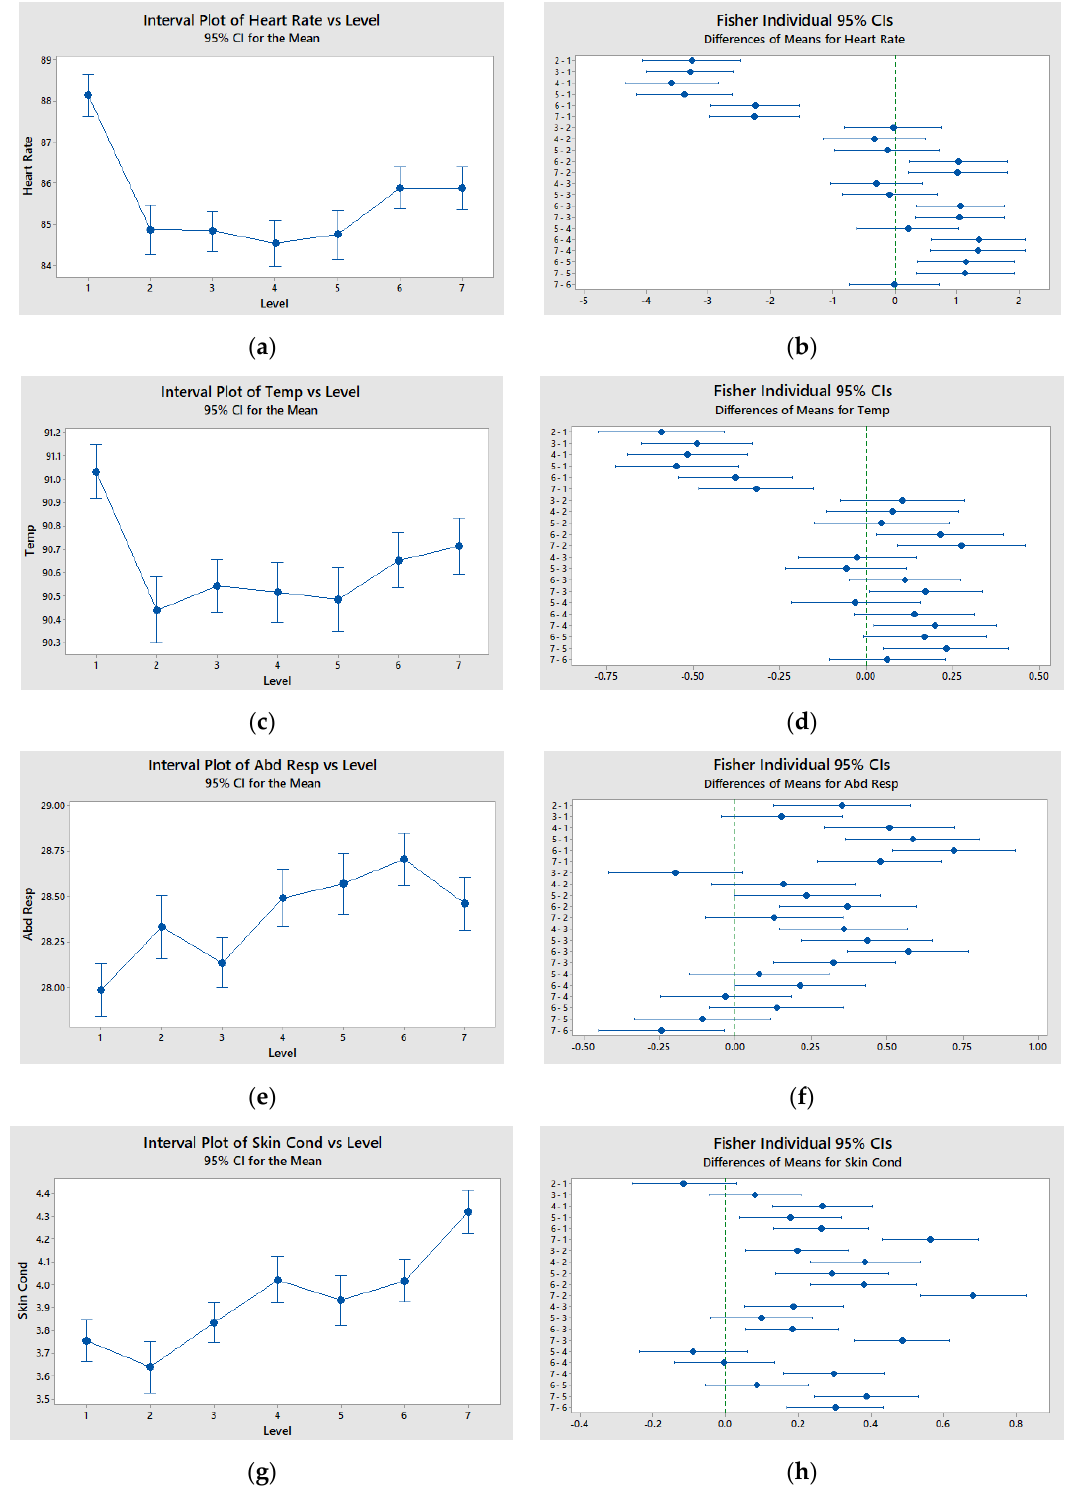
Figure 11. ( a ) One-way ANOVA interval plot of heart rate vs. level; ( b ) Fisher’s least significant difference (LSD) method for multiple comparisons of heart rate vs. level; ( c ) One-way ANOVA interval plot of temperature vs. level; ( d ) Fisher’s LSD method for multiple comparisons of temperature vs. level; ( e ) One-way ANOVA interval plot of respiration vs. level; ( f ) Fisher’s LSD method for multiple comparisons of respiration vs. level; ( g ) One-way ANOVA interval plot of skin conductance vs. level; ( h ) Fisher’s LSD method for multiple comparisons of skin conductance vs. level.